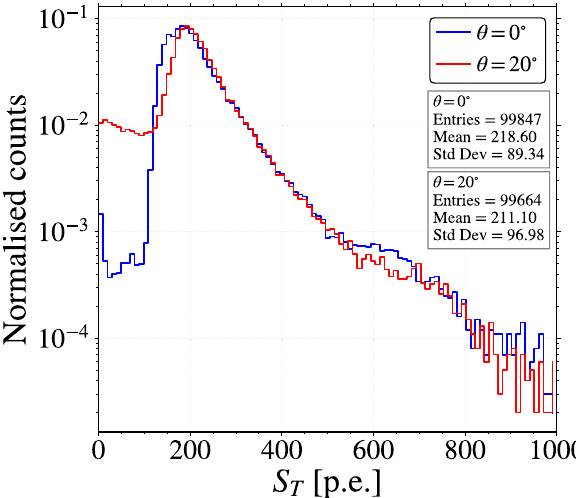
Fig. 3 DistributionoftheexpectedtotalsignalofoneMercedesstation for 2GeV single vertical (blue) and inclined (red) muons